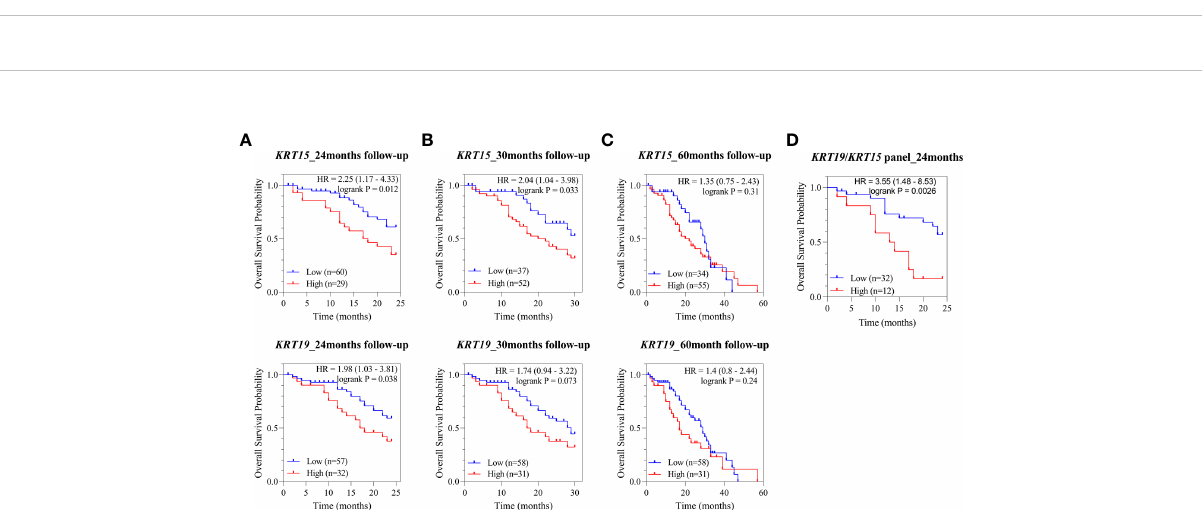
FIGURE 5 Association of KRT15 and KRT19 expression with overall survival. (A) 24-months follow-up. (B) 30-months follow-up. (C) 60-months follow-up. (D) KRT15 / KRT19